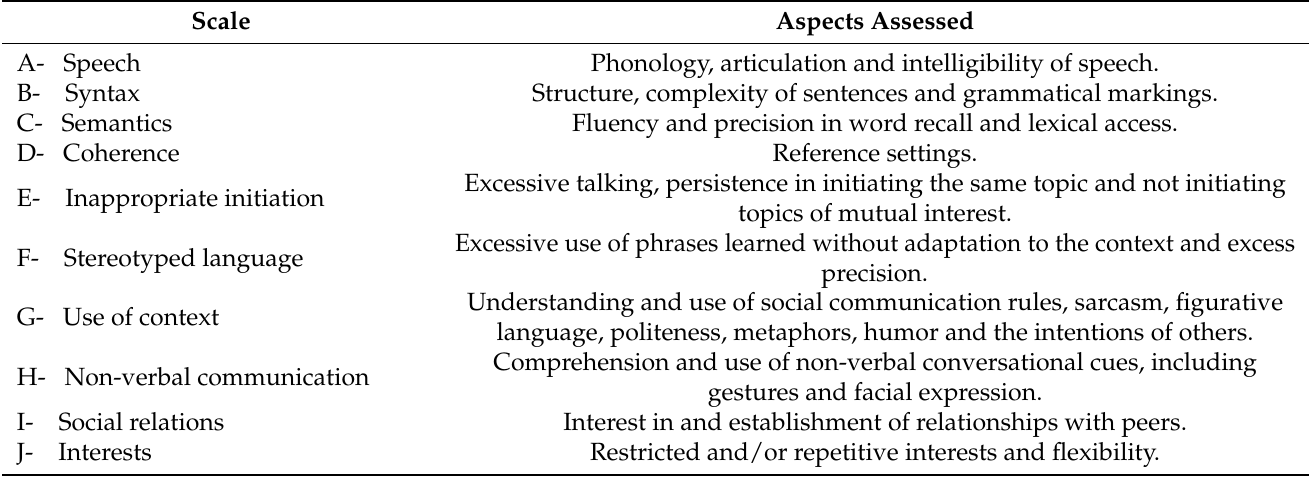
Table 2. Scales of the CCC-2 (adapted from Philofsky et al.